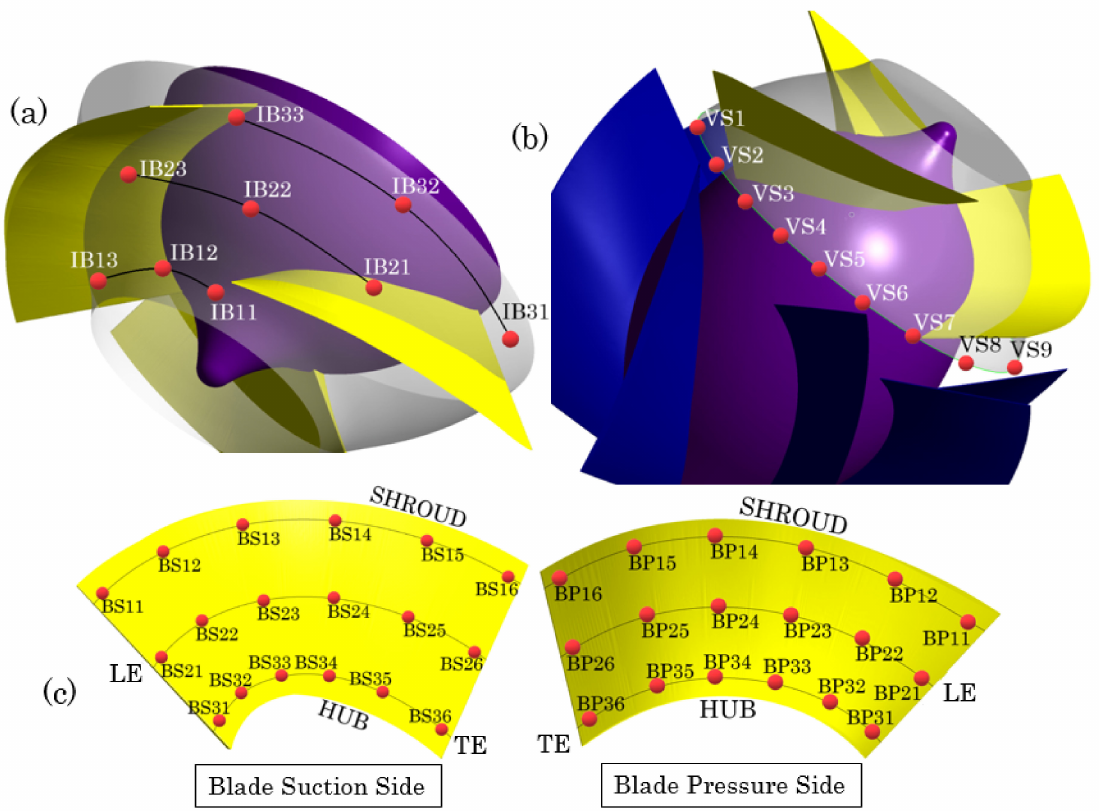
Figure 16. Pressure monitoring locations within the runner flow zone: ( a ) inter-blade mid-span flow zone ( b ) vaneless space flow zone, and ( c ) runner blade’s suction and pressure